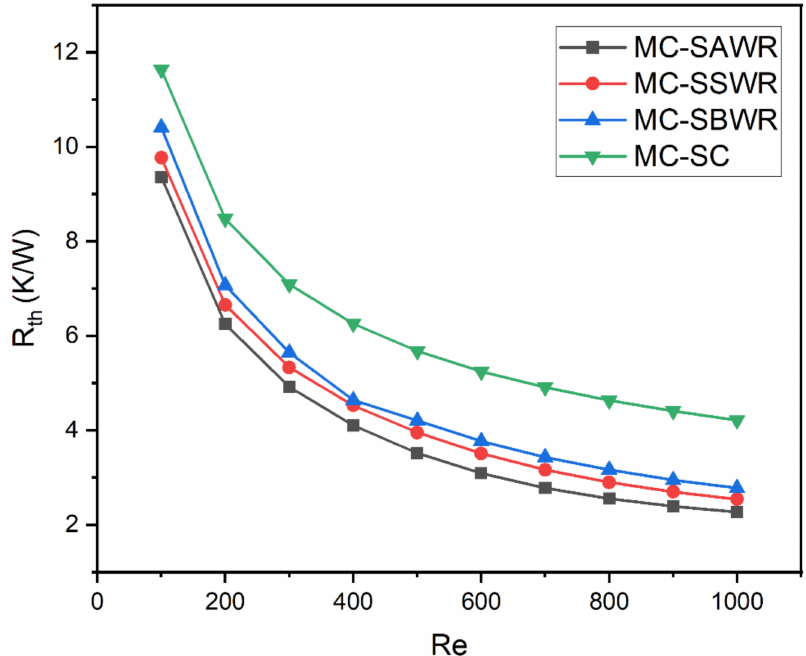
Figure 14. Variation of thermal resistance ( R th ) with Re for different MCHS